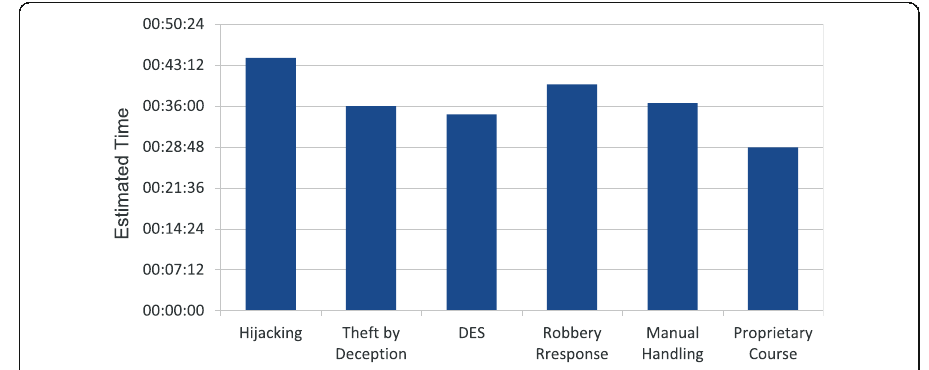
Fig. 9 Average Time of finishing the training part for some